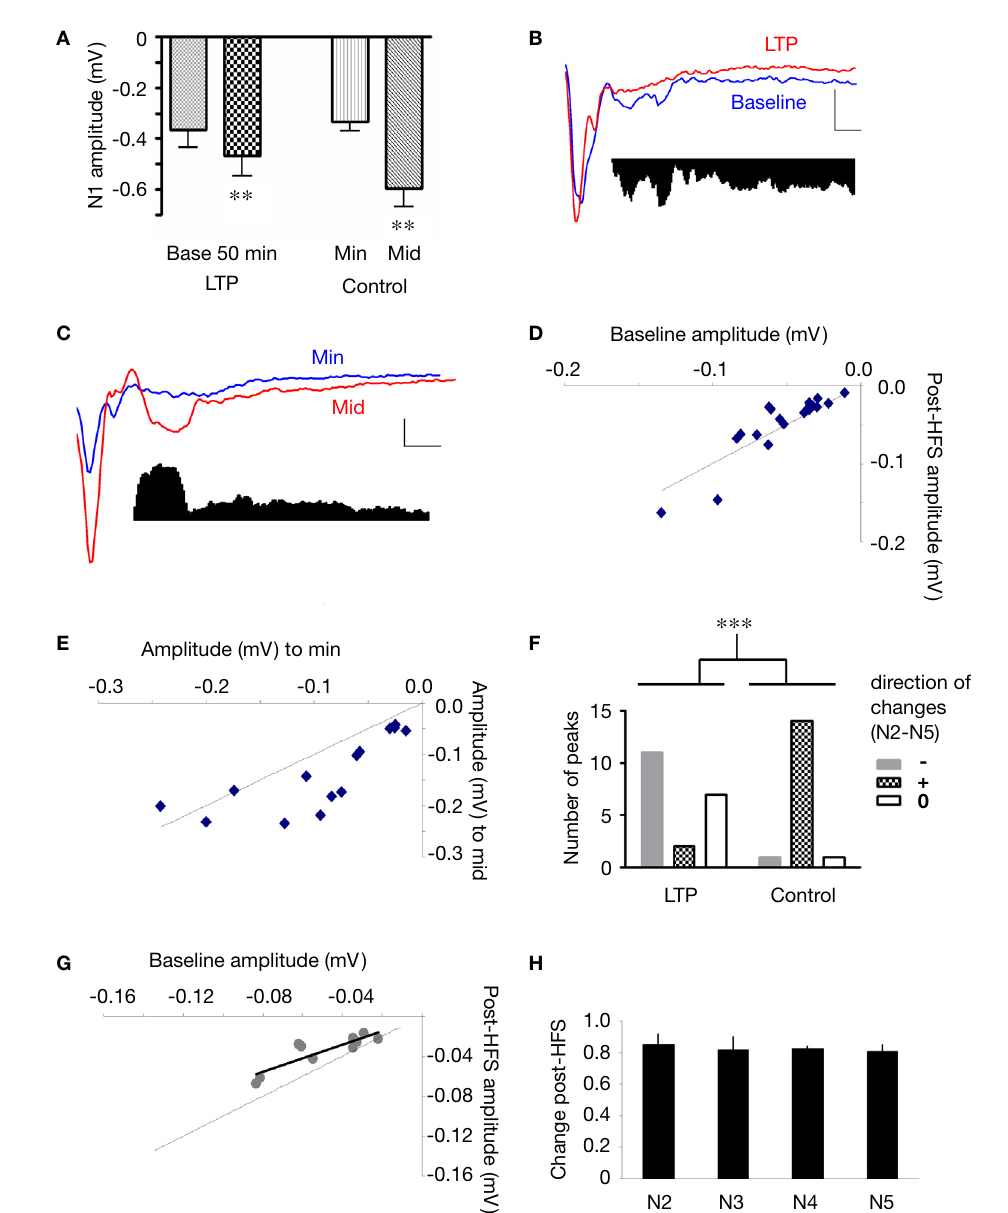
Figure 8 | Effect of thalamo-amygdala LTP on polysynaptic activity in the LAd-s, as compared to an increase in stimulation intensity. (A) Mean change ( + SEM) in N1 amplitude in the LTP experiment (50-min post-tetanus vs. baseline) and in the control experiment (minimum vs. middle intensities). Current intensity was delivered at ≈ 33% (minimum, min) and ≈ 66% (middle, mid) of current needed for maximal N1 amplitude. Both LTP and control show a signifi cant increase in N1 amplitude. (B) Example traces of baseline (blue) and after LTP (red). Inset, difference in area under trace of polysynaptic activity (N2–N5) shows a decrease in polysynaptic activity. (C) Example traces of control experiment, min (blue) and mid (red) intensities. Inset, difference in area under trace of polysy- naptic activity (N2–N5) shows an increase in polysynaptic activity. (D) Change in peak amplitude for all TLPs (N2–N5) in LTP group. Most peaks were decreased after LTP (line = no change, baseline vs. LTP). (E) Change in peak amplitude for all TLPs (N2–N5) in control experiment. Most peaks were increased with intensity (line = no change, min vs. mid). (F) The number of TLPs (N2–N5) that were increased, decreased or not changed was signifi cantly different between the LTP and control experiments. (G) In the depressed cases from LTP experiment, the decrease in peak amplitude was linearly correlated to its initial baseline value. (H) Mean ratio of change in peak amplitude after LTP shows the constant suppression ratio for all TLPs